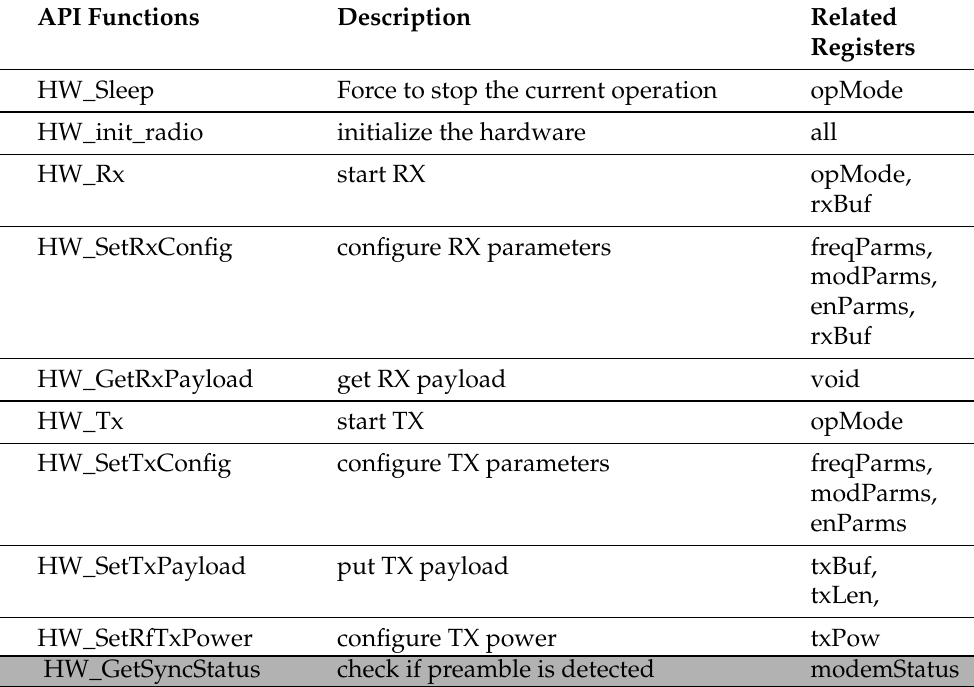
Table 6. The modified function sets of the hardware-interface entity for the RXW prolonging